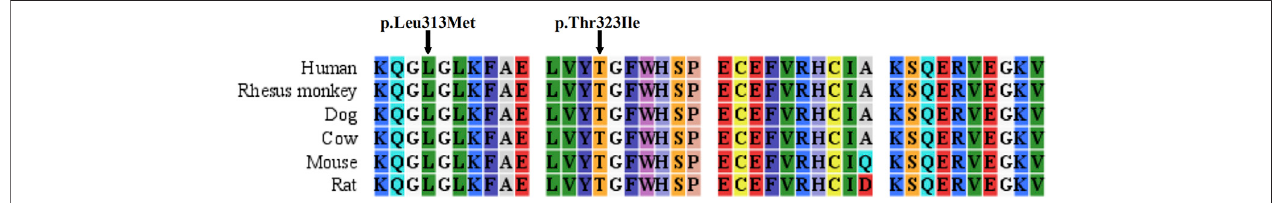
FIGURE 1 | Sequence alignment of ASS1 proteins among species.